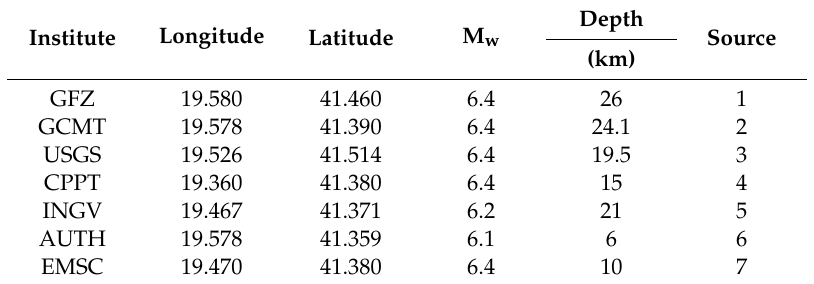
Table 1. Determination of the parametric data of the Nov. 26, 2019 02:54 UTC earthquake by various